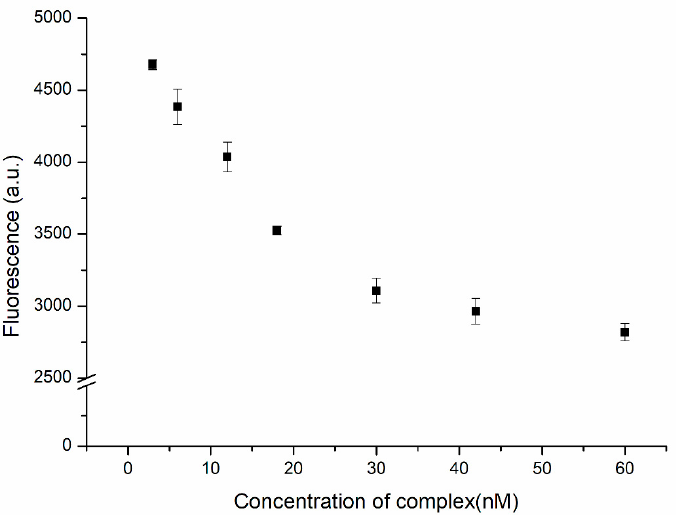
Figure 3. Fluorescence intensity of ATMND (30 nM) in the presence of the DNAzyme complex (3, 6, 12, 18, 30, 42, and 60 nM).